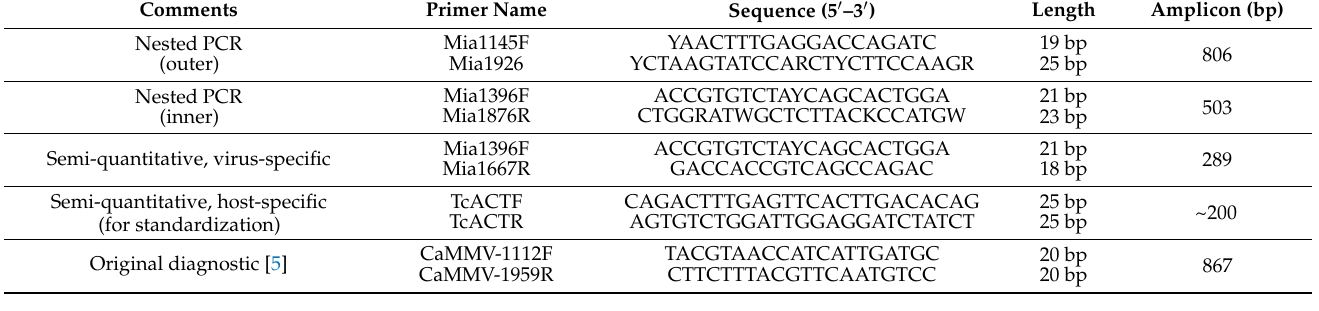
Table 1. Primer pairs used for CaMMV detection and localization in this study.